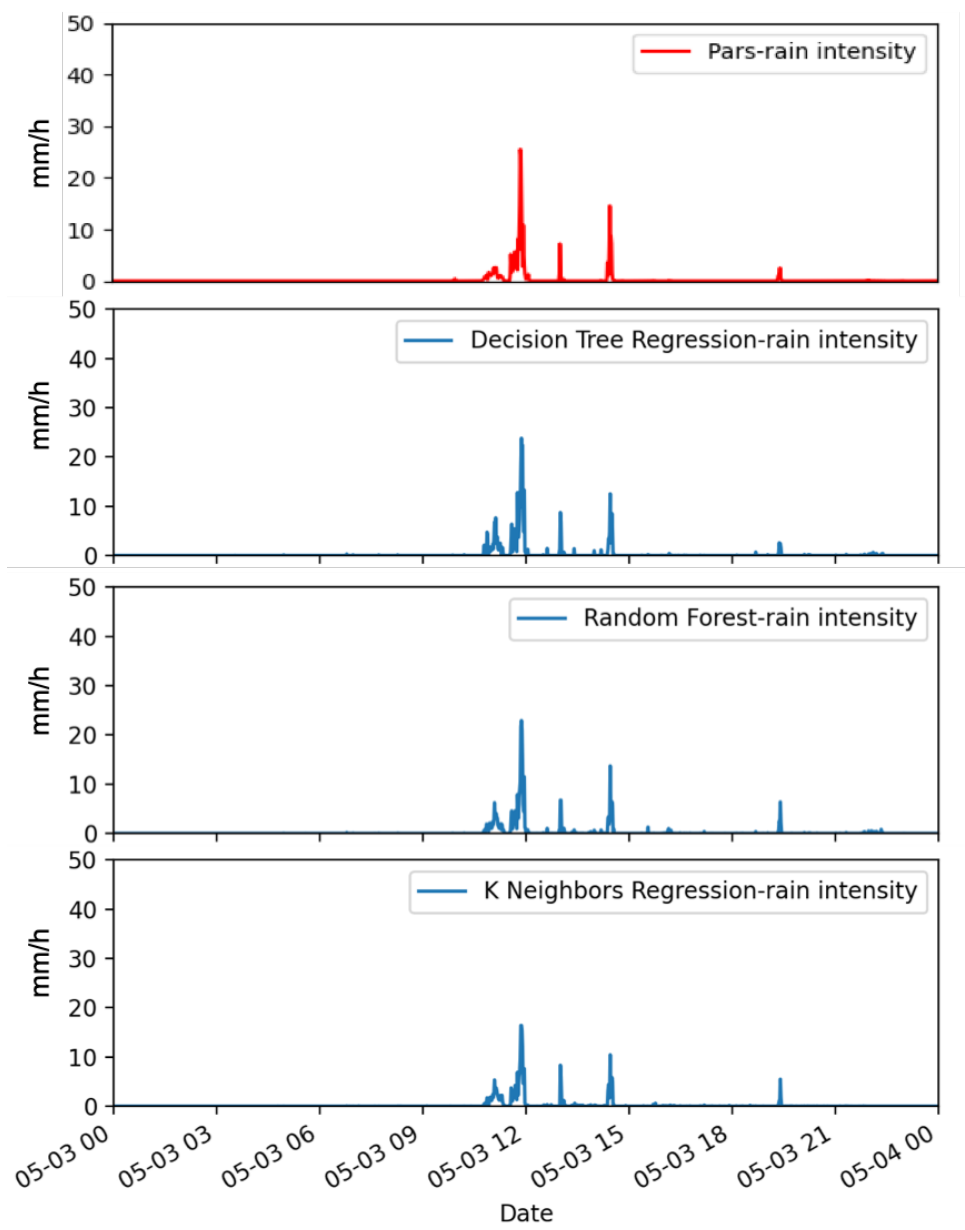
Figure 5. Instantaneous rainfall rate as measured by a co-located reference laser disdrometer (on top) and as estimated by the ML (DTR, RF, KNNR) approaches (from top to bottom, respectively). Data are relative to 3 May